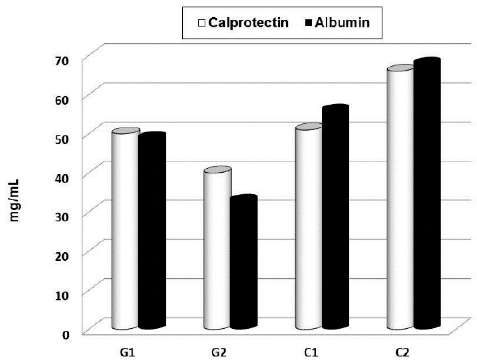
Figure 6. Effects if 30 days oral administration of glucan on calprotectin and albumin levels in saliva. G—glucan group, C—placebo group.